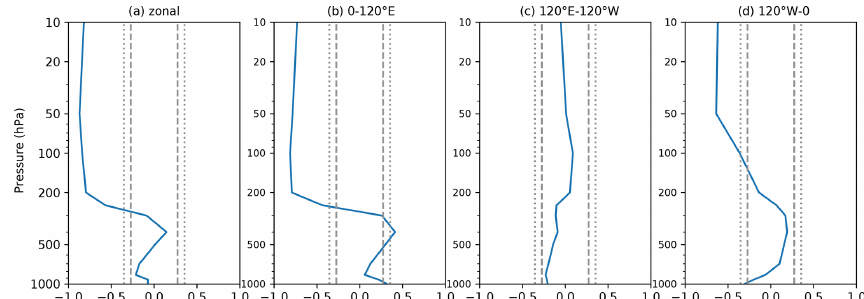
Figure 8. Vertical distribution of the correlation coefficient between the vertical component of the WAF forecasts averaged during 4– 11 February and U10 forecasts valid on 12 February across individual forecast ensemble members. (a) Zonally averaged; (b) averaged over 0–120 ◦ E; (c) averaged over 120 ◦ E–120 ◦ W; (d) averaged over 120–0 ◦ W. Dashed vertical lines denote the 0.05 significance level; dotted vertical lines denote the 0.01 significance